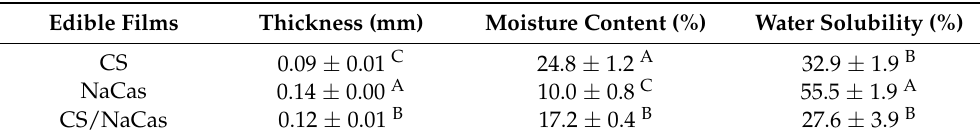
Table 1. Thickness, moisture content, and water solubility of chitosan, sodium caseinate, and composite edible